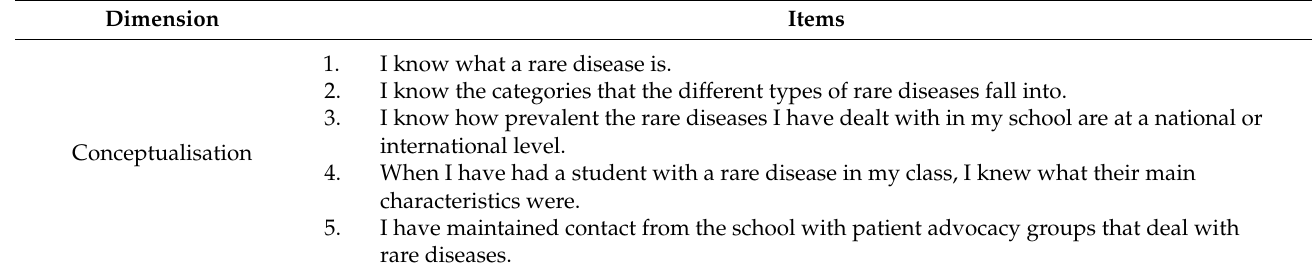
Table 1. Structure of the teachers’